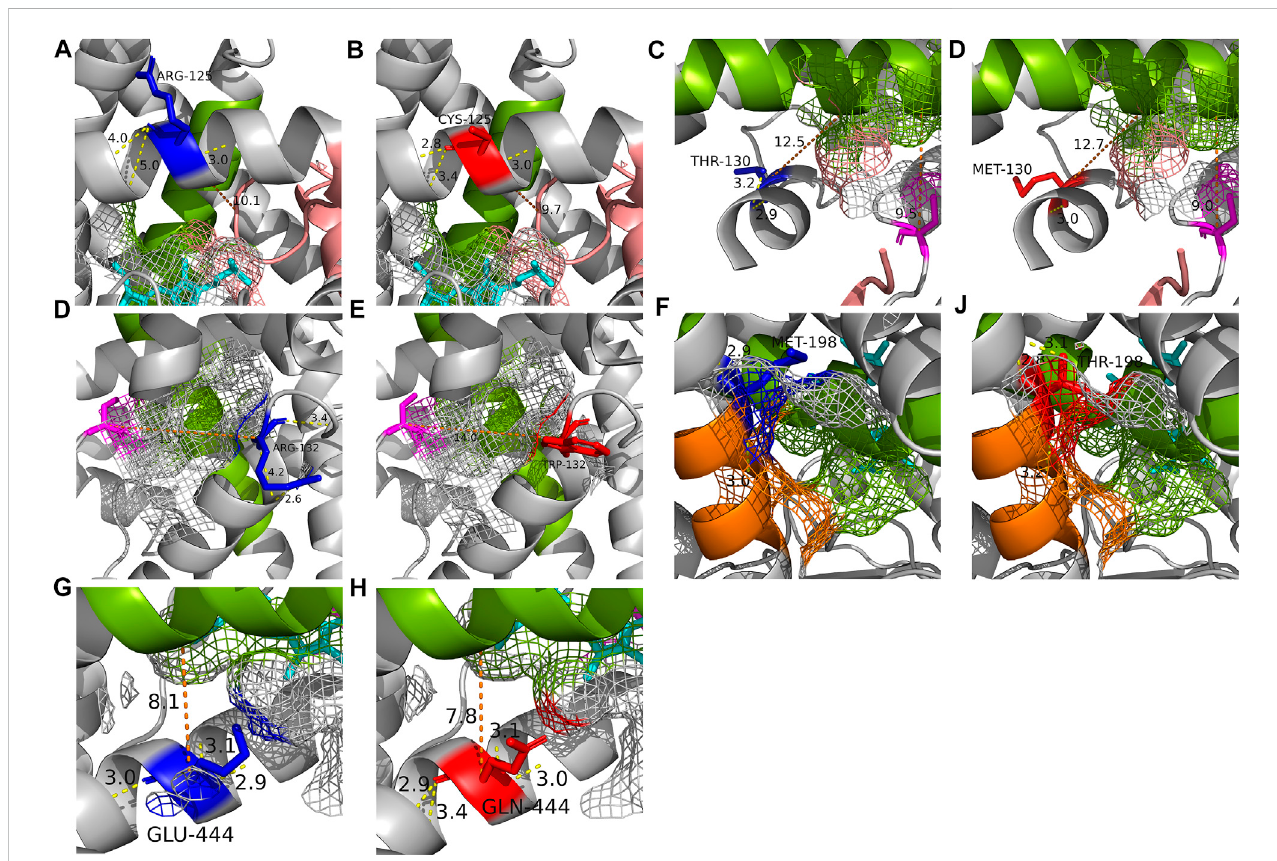
FIGURE 5 The crystal structure of each of the fi ve altered residues and their surrounding area to compare the structural effects with WT (PDB: 4GQS). (A, B) Stereoscopic structures of Arg125 (WT) and Cys125. (C, D) Stereoscopic structures of Thr130 (WT) and Met130. (E, F) Stereoscopic structures of Arg132 (WT) and Trp132. (G, H) Stereoscopic structures of Met198 (WT) and Thr198. (I, J) Stereoscopic structures of Glu444 (WT) and Gln444. The blueresidueis WT form of the residue and the red is altered form of the residue. The magenta residue is the active site and heme is shown as cyan. The SRSs are shown in